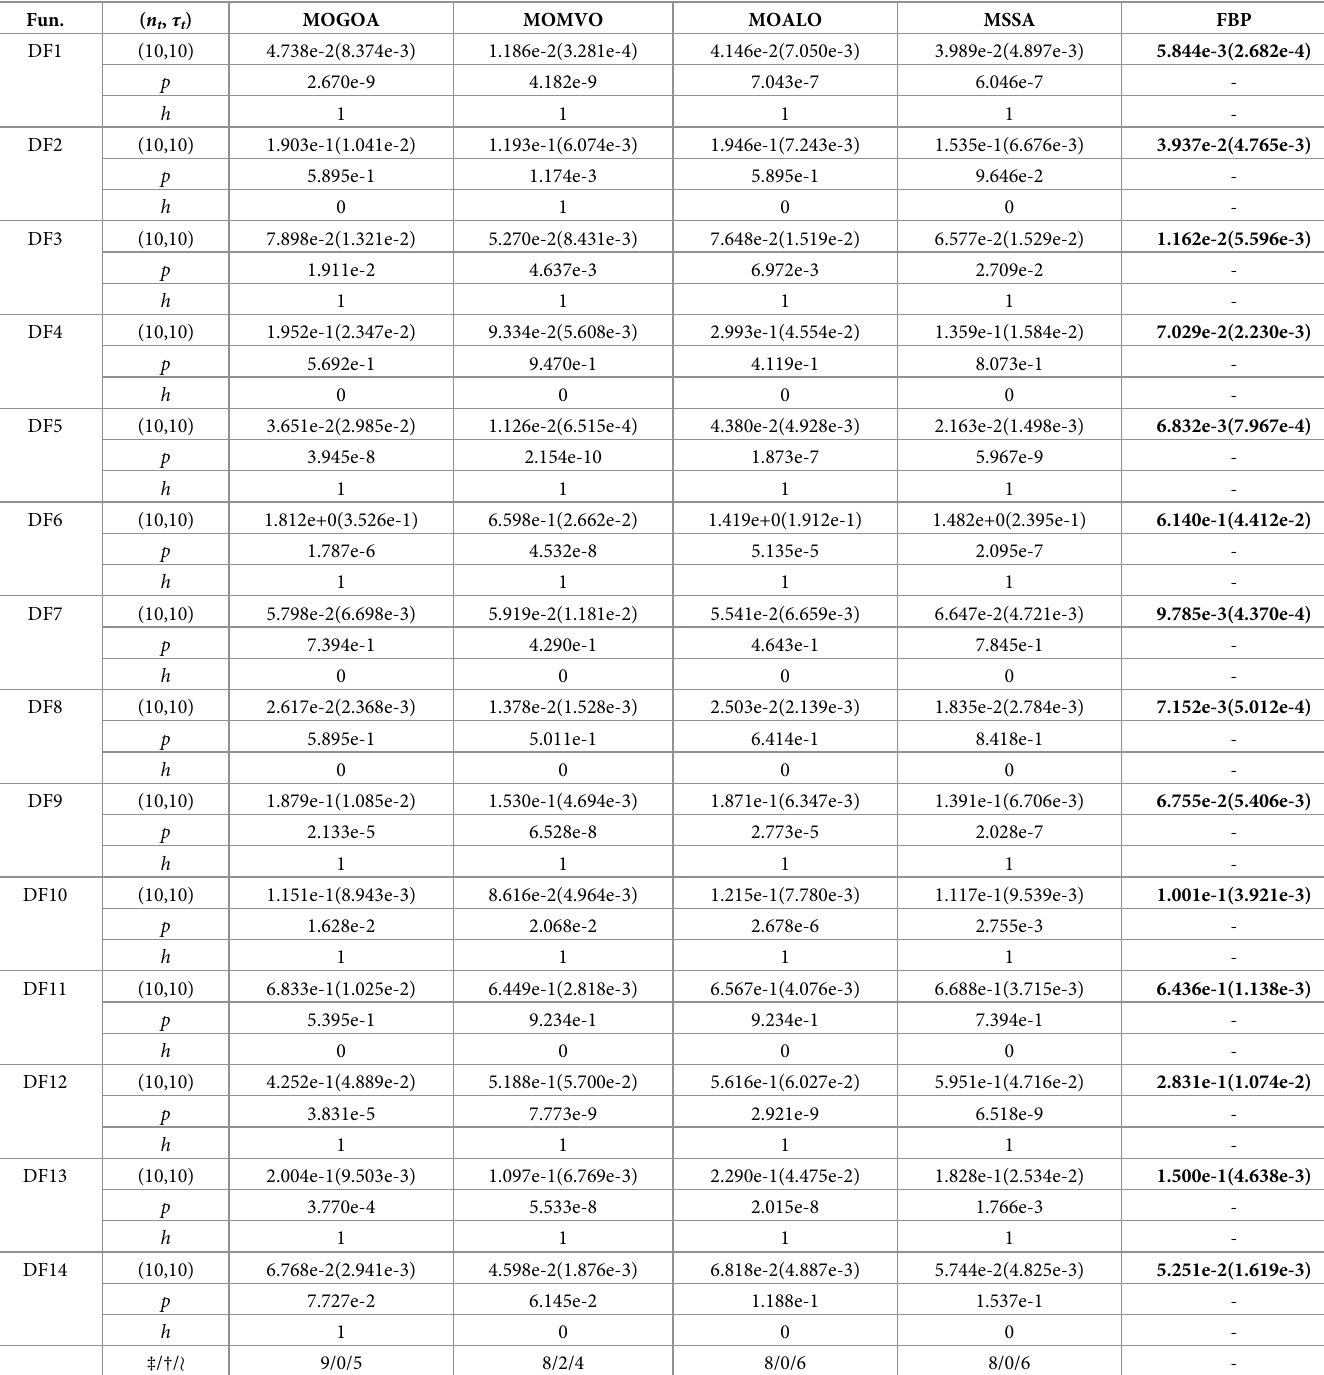
Table 10. Performance comparison of different multiobjective algorithms variants on MIGD.